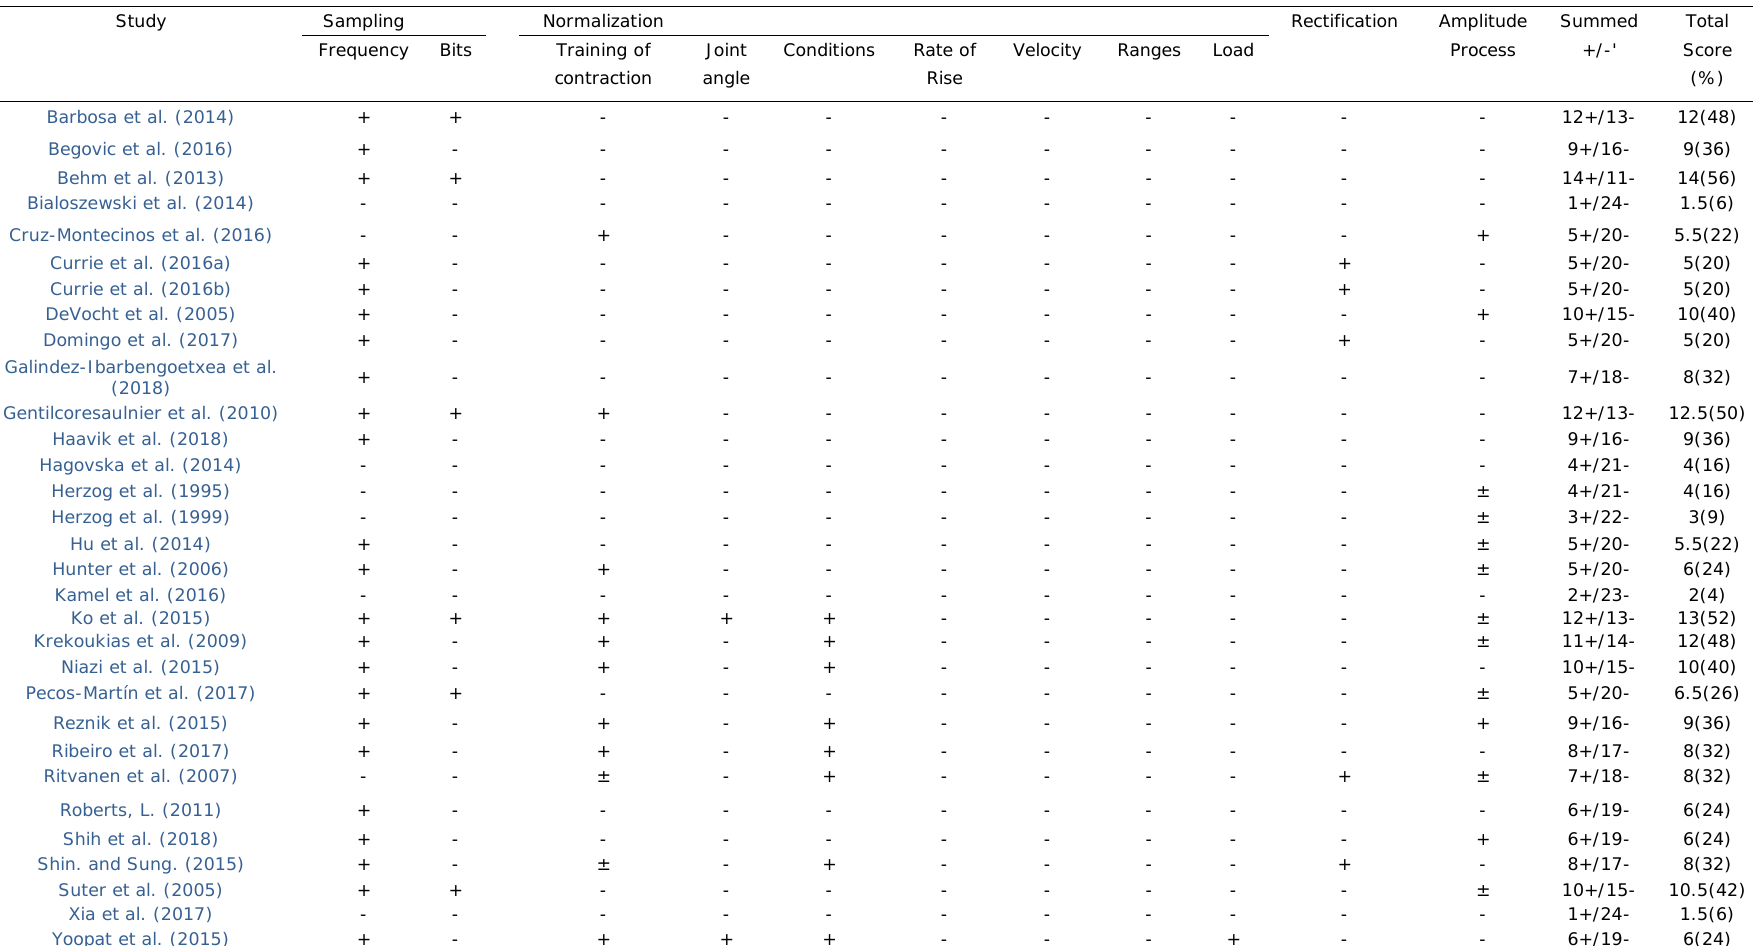
Table 5. Check-list for the ISEK standards for reporting EMG data. Format adapted from Januario et al., (2016)